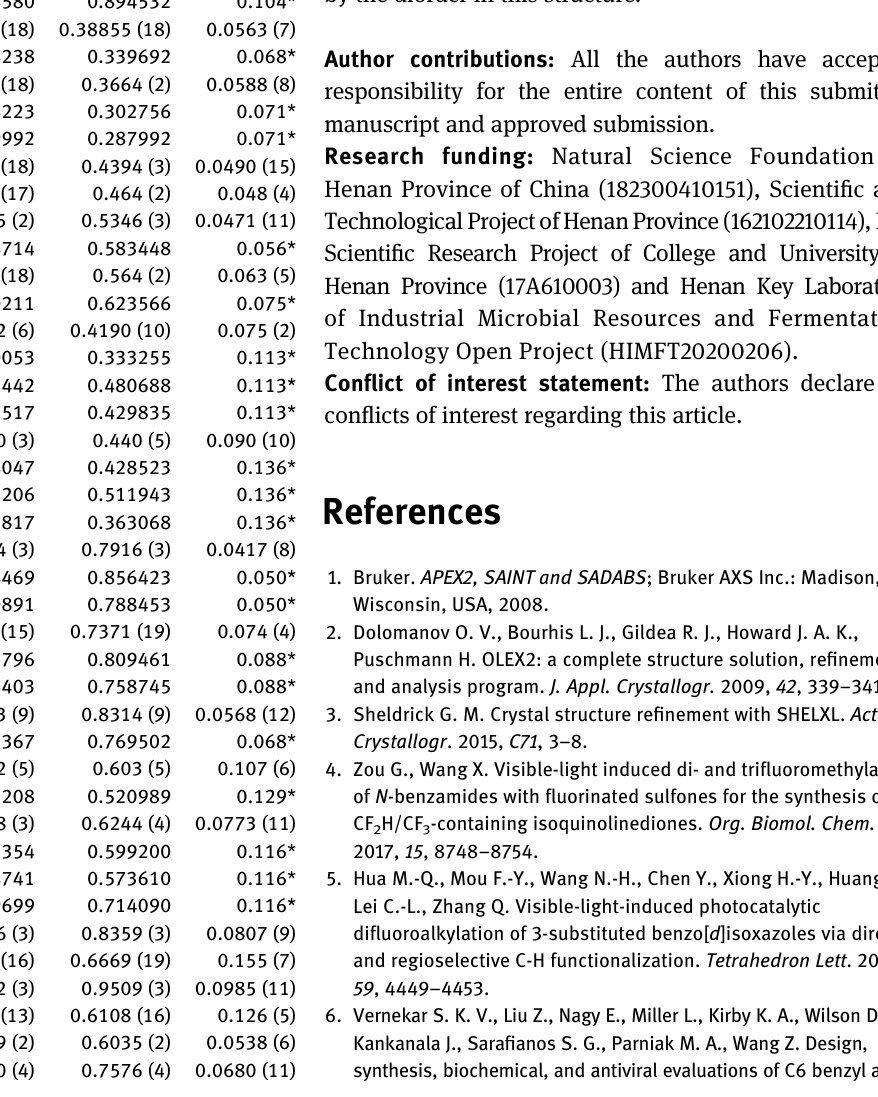
In the asymmetric unit of the crystal structure, the C=O bond lengths of 1.218(5) and 1.213(3) Å show typical double- bond character. The central six-membered ring [C1/N1/C2/ C3/C4/C5] is slightly deviated from planarity, the mean deviation from the plane of 0.0225 Å (see the Figure). The deviation of N1 is the highest, 0.0344 Å. In the crystal structure, the molecules are linked into three-dimensional frameworks by weak C — H ⋯ F and C — H ⋯ O hydrogen bonds. All geometric parameters may be slightly affected by the diorder in this structure.